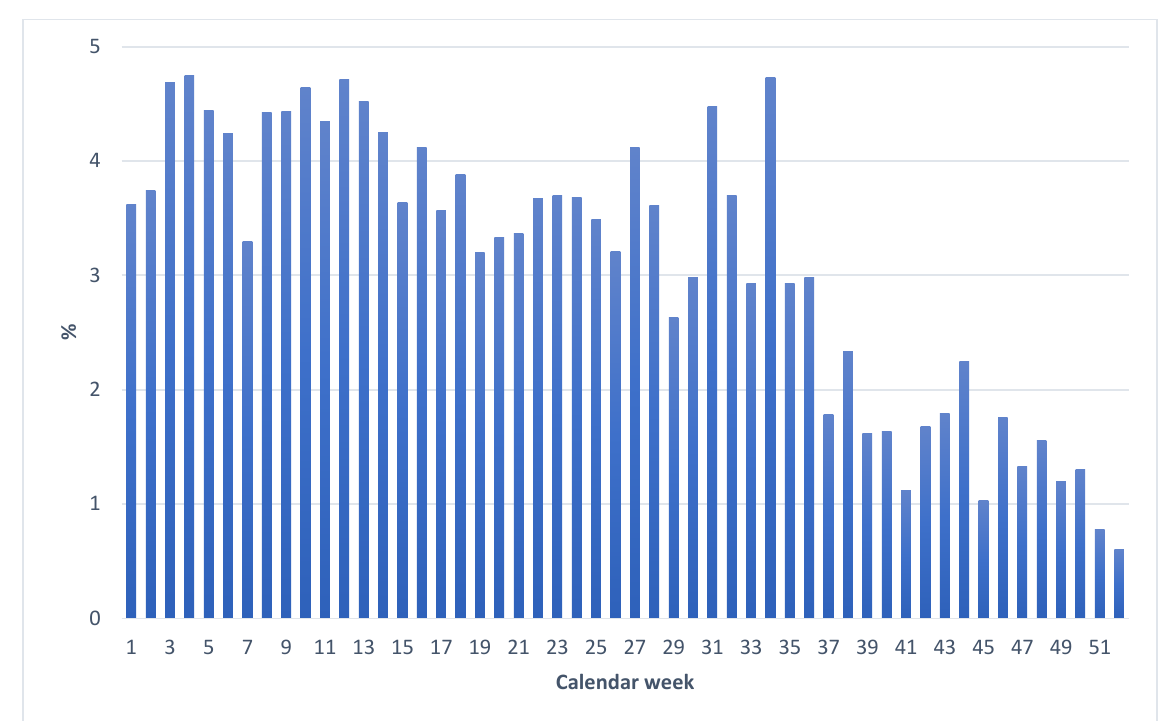
Figure 2. Proportion of cases (%) involving inpatient treatment among the reported cases in the respective calendar weeks of 2021.